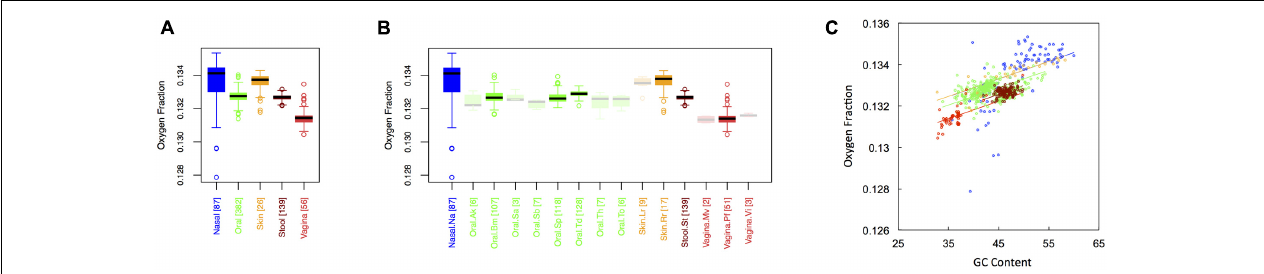
FIGURE 2 | Boxplots showing the average oxygen content of microbial proteins as a function of human body site for (A) the 5 major sites and (B) the 15 minor sites in our study. The number of samples from each site is indicated in square brackets on axis labels. Faded boxes are used for sites with fewer than 10 samples. Differences in oxygen content were tested with Dunn’s test. Statistics are summarized in Appendix II, Tables A.2.4, A.2.5; (C) Scatterplot of oxygen content versus GC content with associated regression lines from our ANCOVA analysis for major body sites: nasal (blue), oral (green), skin (yellow), stool (brown), and vaginal (red).